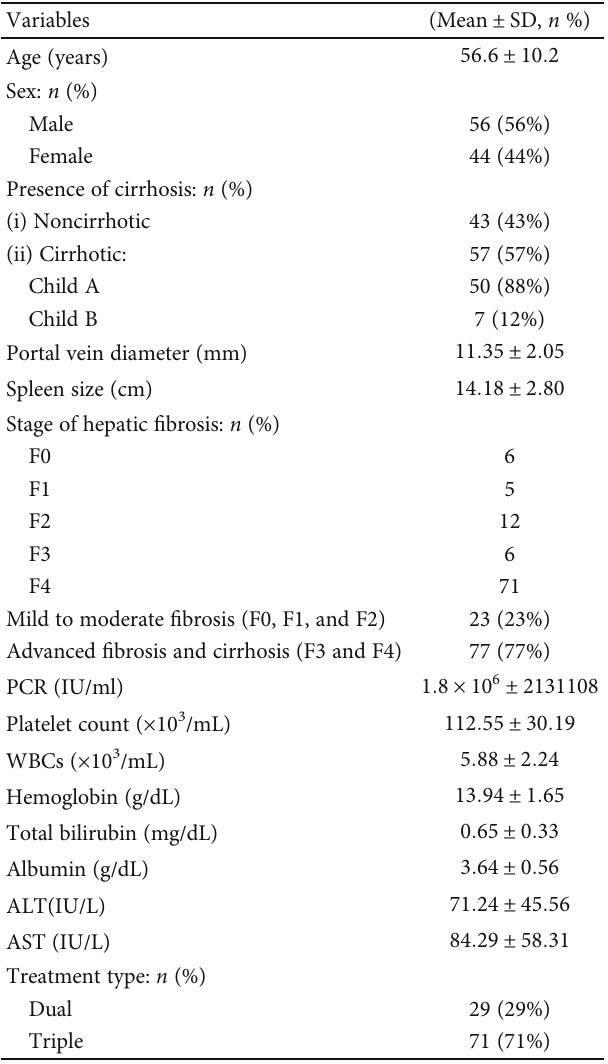
Table 1: Baseline characteristics of the studied